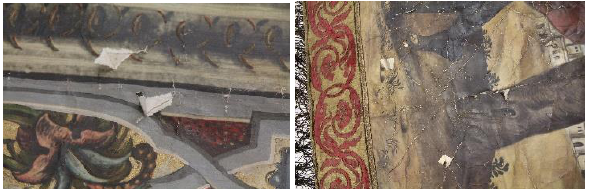
Figure 6 – Examples of superficial laceration on banners S. Vincent (left) and S. Roque